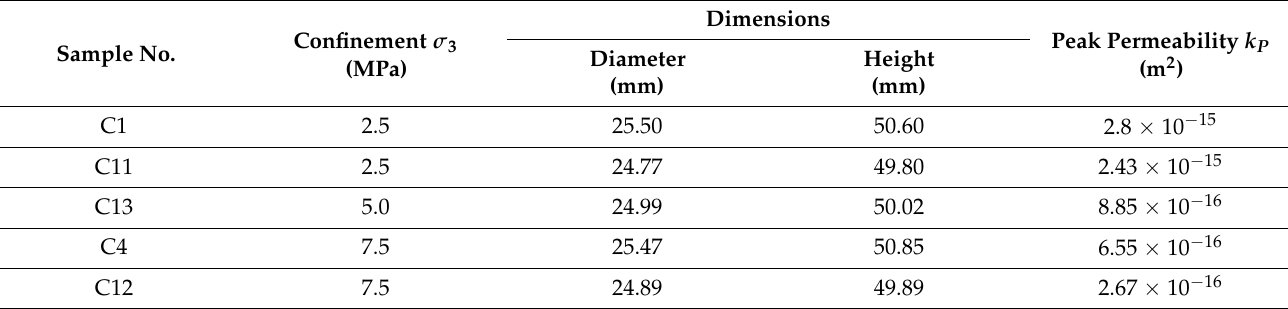
Table 4. Measured values of permeability (coal